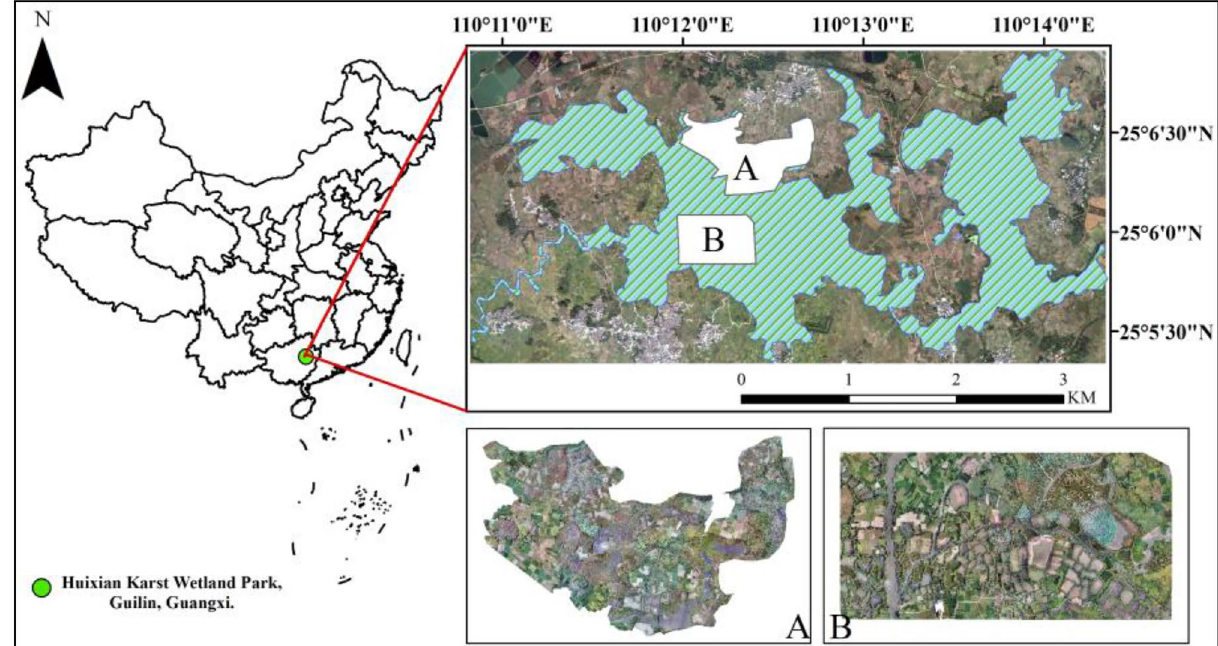
Figure 1. The study area and the location (Area A and B are UAV ortho-images collected by B. F. using the DJI Phantom 4 Pro professional V2.0 drone). ArcGIS 10.6 software (http:// www. esri. com/ softw are/ arcgis) was used to process and map the data by first author (T. D.) and corresponding author (B. F.). The Map of China (left) is credited to the SinoMaps Press, previously known as China Cartographic Publishing House.